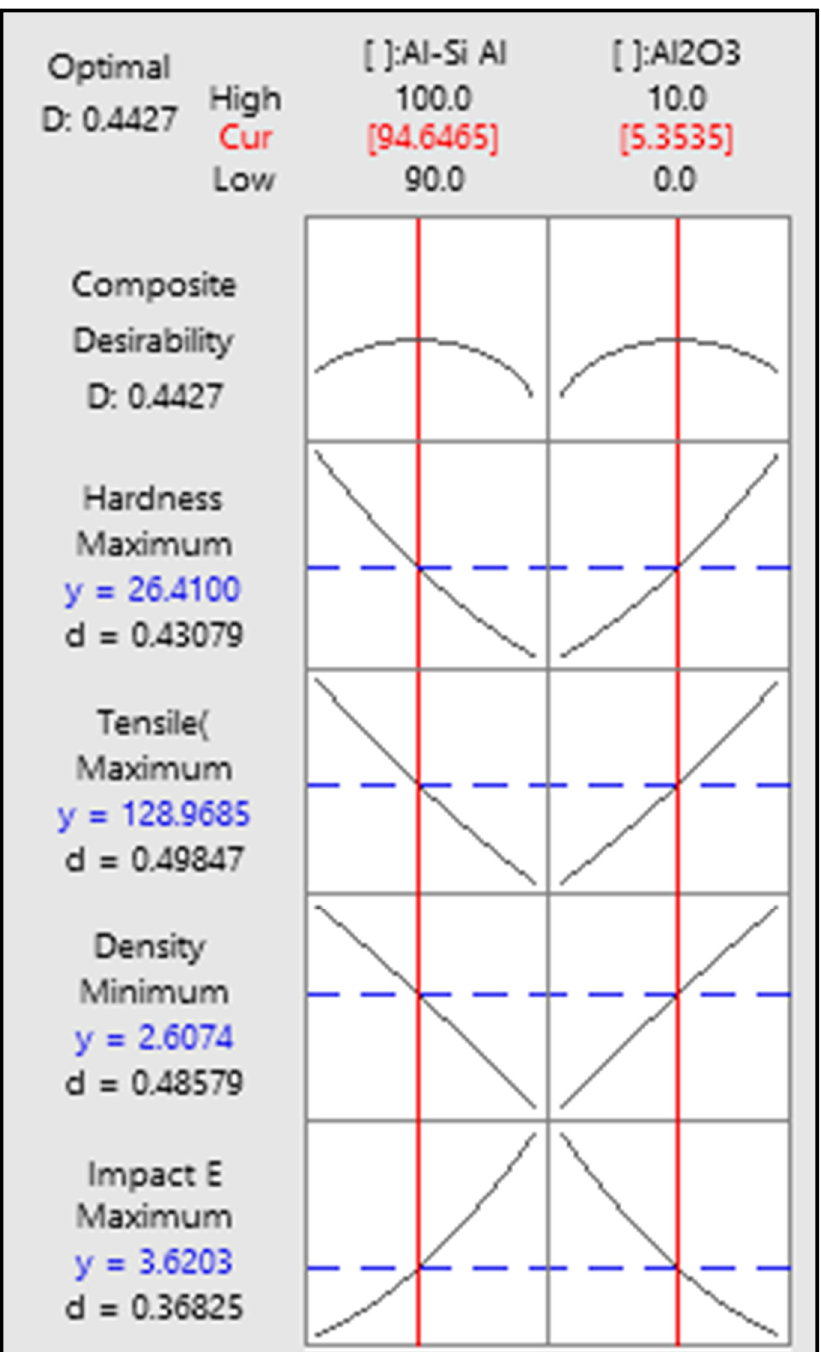
Figure 6. Response Optimiser